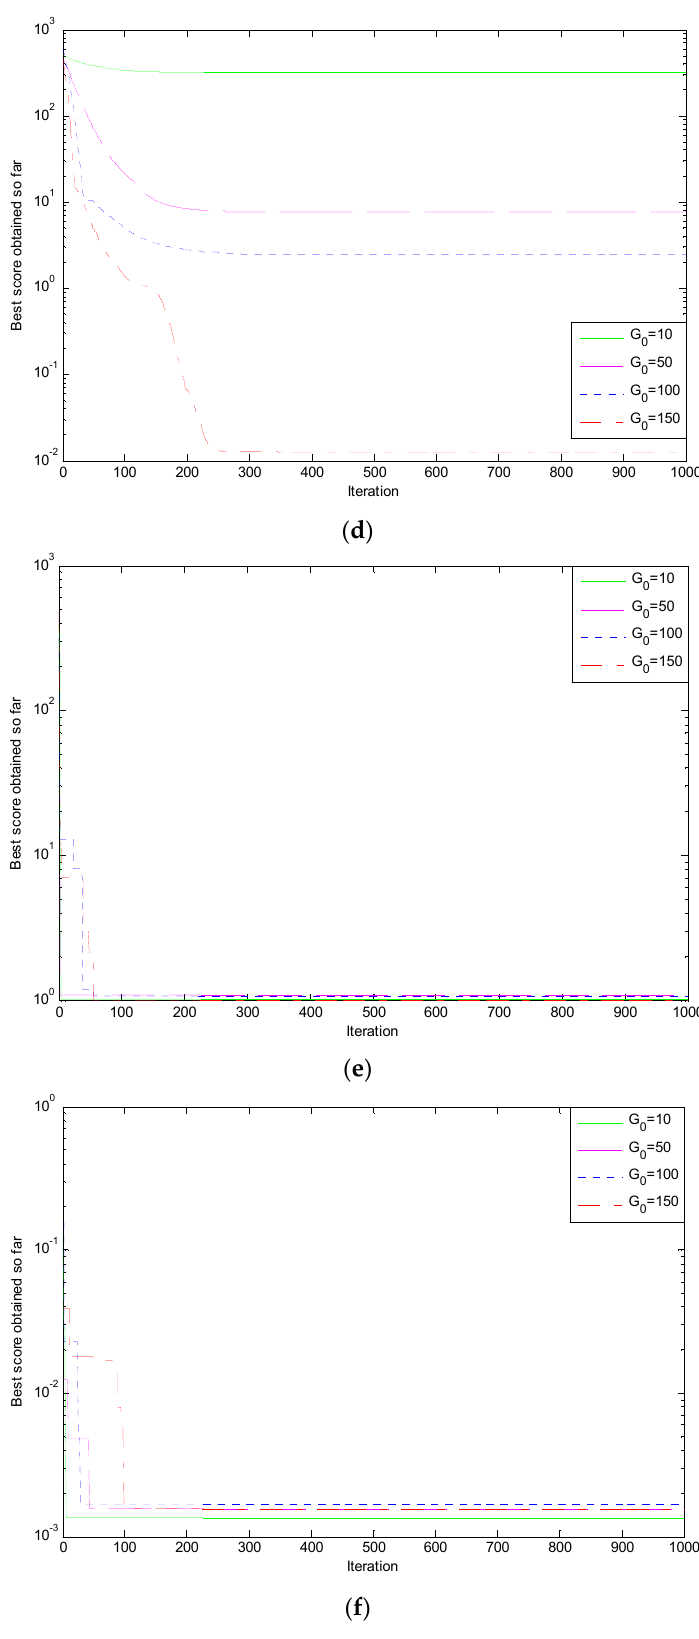
Figure 3. Simulation results of six typical test functions. ( a ) Griewank function; ( b ) Quartic function; ( c ) Rastrigin function; ( d ) Schwefel function; ( e ) Shekel’s Foxholes function; ( f ) Kowalik’s function.